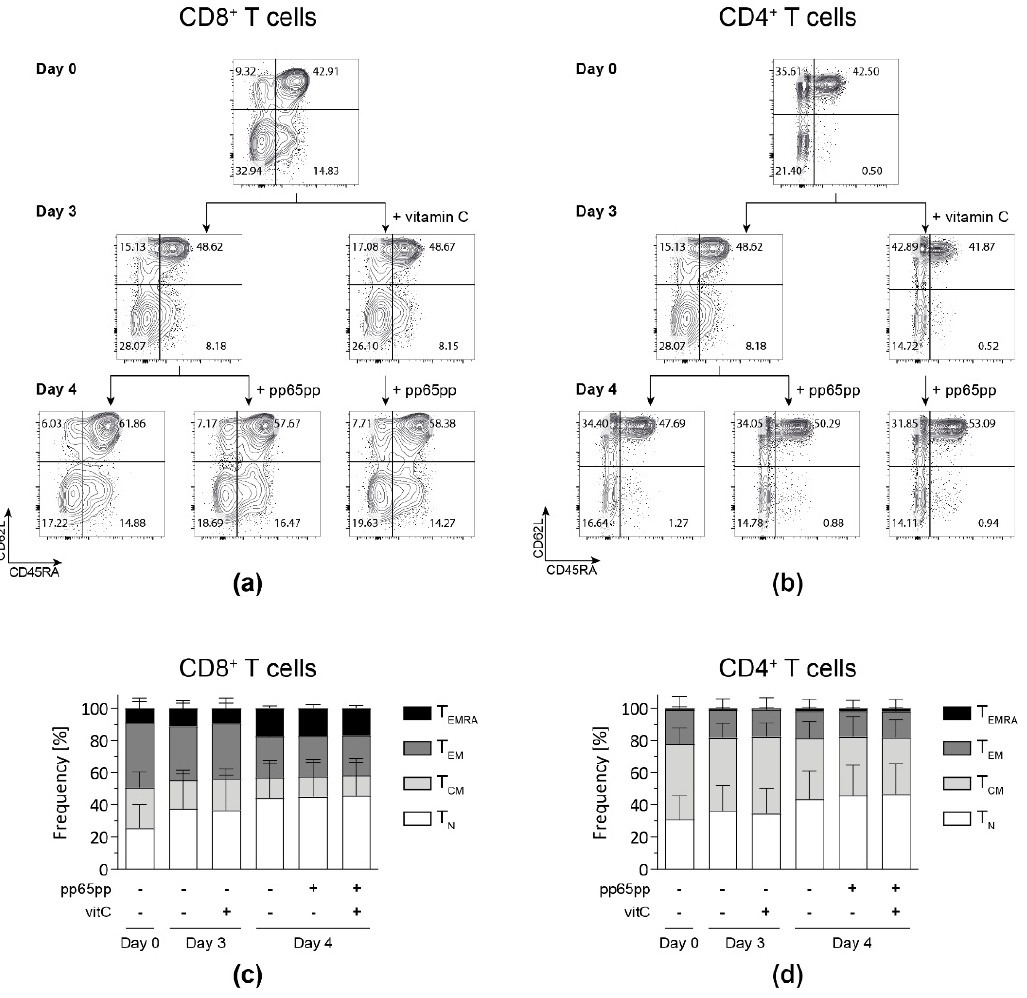
Figure 5. Vitamin C alone does not affect the memory phenotype distribution yet increases the fraction of T EMRA after antigenic stimulation. After PBMC isolation, cells were incubated with (+vitamin C) or without vitamin C for 3 days. On day 3, part of the untreated and all treated cells were stimulated overnight with pp65pp. CD45RA and CD62L expression were measured by flow cytometry on days 0, 3, and 4. Cells are gated on viable CD8 + and CD4 + T cells based on scatter properties (FSC-A/SSC-A), 7-AAD staining as well as CD3, CD8 and CD4 expression. Representative contour plots show percentages of naïve T cells (T N ; CD45RA + CD62L + ), central memory cells (T CM ; CD45RA - CD62L + ), effector memory cells (T EM ; CD45RA − CD62L − ) and late effector memory cells (T EMRA ; CD45RA + CD62L − ) among CD8 + ( a , c ) and CD4 + ( b , d ) T-cell subsets. Data are shown as representative ( a , b ) and summarized results ( c , d ) from n = 5 donors. Bar graphs represent mean and SD. 3.6. Vitamin C Enhances IFN- γ Secretion by CD45RA + T Cells In order to assess the influence of vitamin C on the functionality of the different phenotypic subsets of CMV-specific T cells, responses of total PBMCs were compared to cell fractions that were selected based on their CD45RA or CD62L expression. Both of these selection methods were available for the GMP-compliant use in clinical manufacturing and thereby were potentially applicable for VST generation. Functionality of T-cell subsets was assessed by IFN- γ ELISpot assay after pp65pp stimulation and vitamin C supplementation.